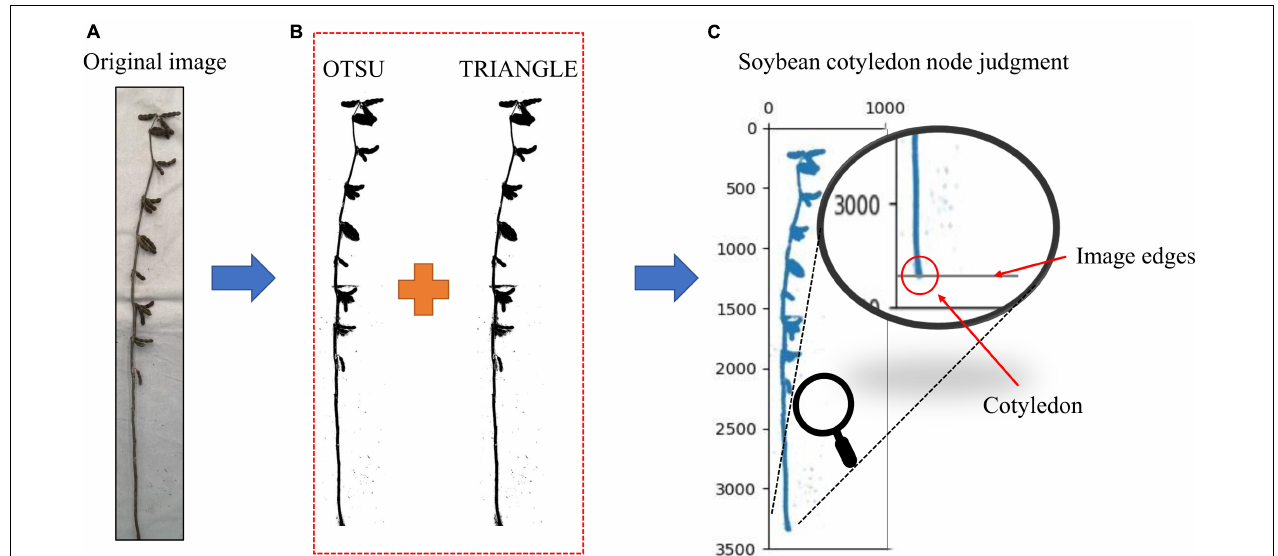
FIGURE 6 | (A) Original image, (B) Image after binarization, and (C) Judgment of soybean cotyledon nodes. Judgment of soybean cotyledon node.